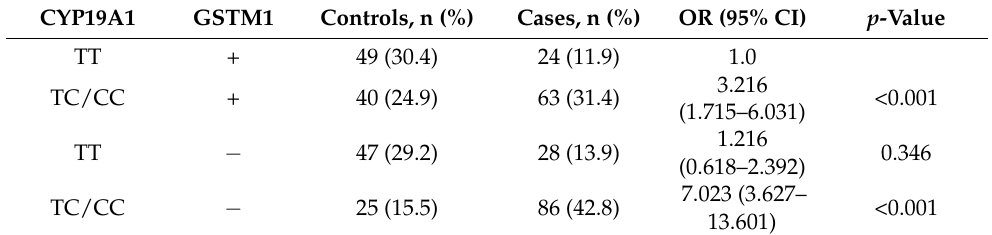
Table 9. Association between CYP19A1 and GSTM1 genotype combinations and female infertility.